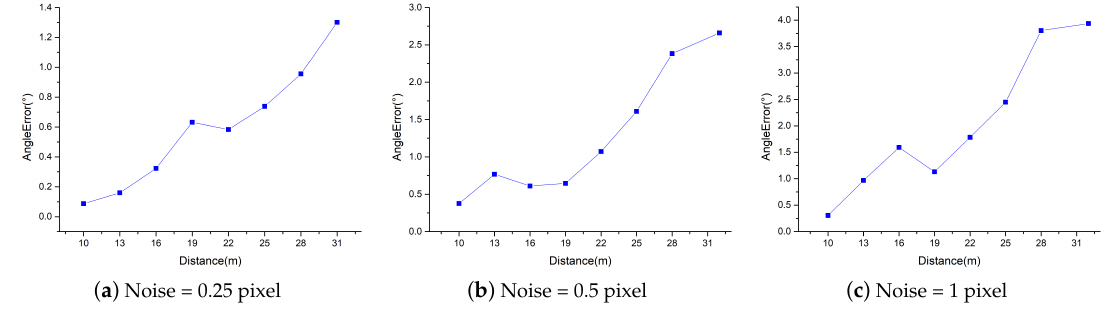
Figure 8. The error of the angle